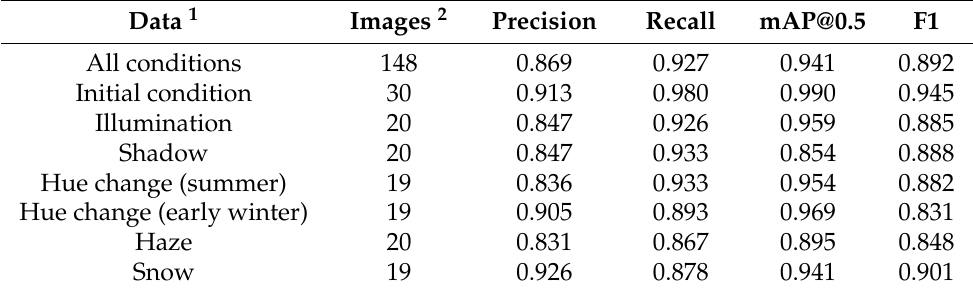
Table 4. YOLOv3 model (trained in Step 3) performance for detecting bales in different conditions after being trained with the synthetic images from Step 2.